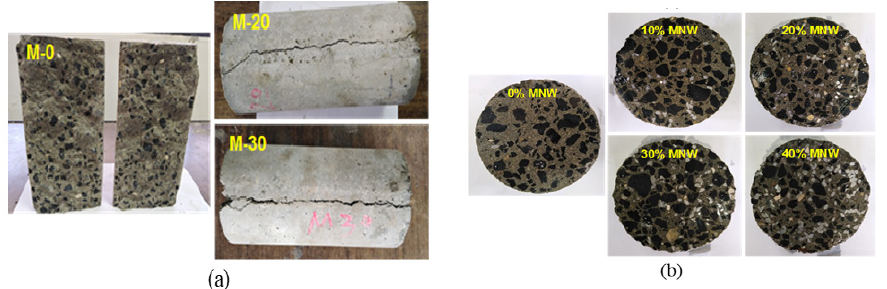
Figure 5. Effects of MNW on failure mode and distribution shape in concrete. ( a ) Failure mode due to tensile test. ( b ) Distribution shape of MNW